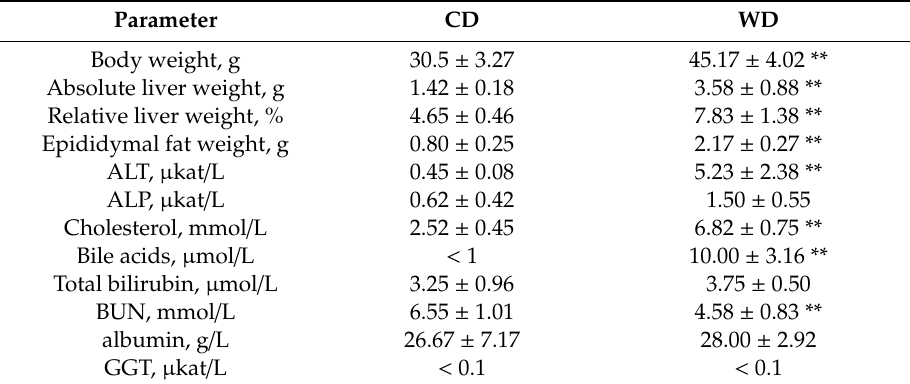
Table 1. Phenotype and blood biochemistry.